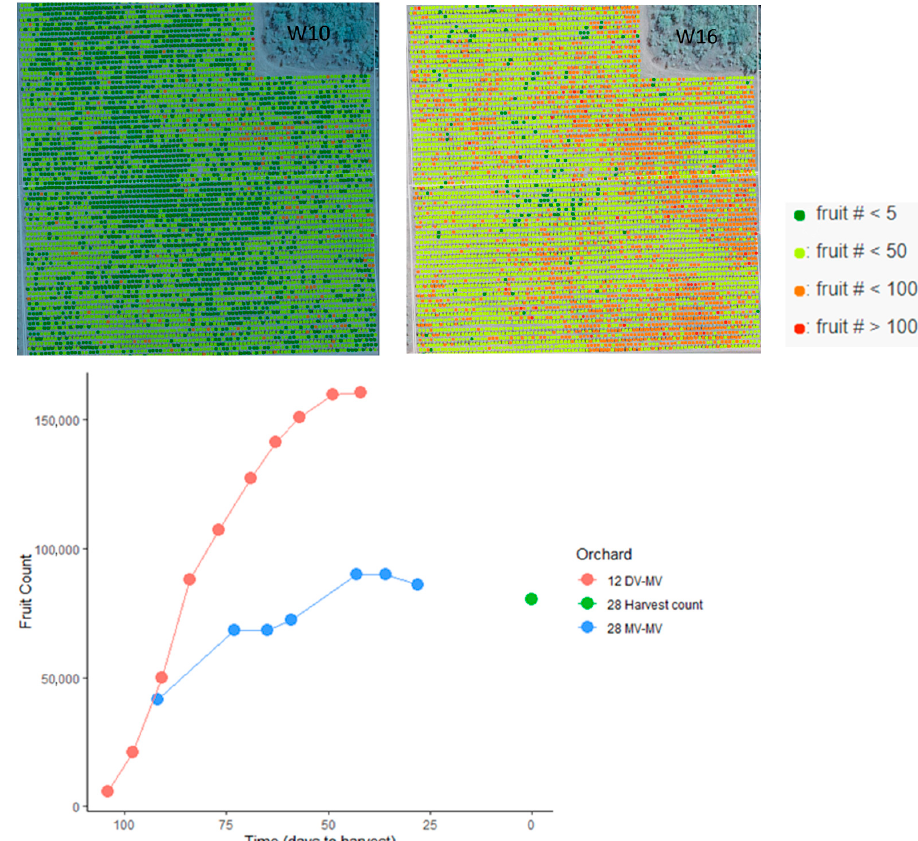
Figure 5. Top panel: Fruit count per tree by dual-view machine vision at 10 and 16 weeks (left and right panels, respectively) from flowering for orchard 12 (2018–2019). Each dot represents a tree side, with color indicating fruit number. Bottom panel: Time course of fruit count for the same orchard (orange) and for orchard 28 (2020–2021 season) (blue). Harvest occurred 6 and 4 weeks after the last assessment, respectively. Packhouse count for orchard 28 is shown at time 0.